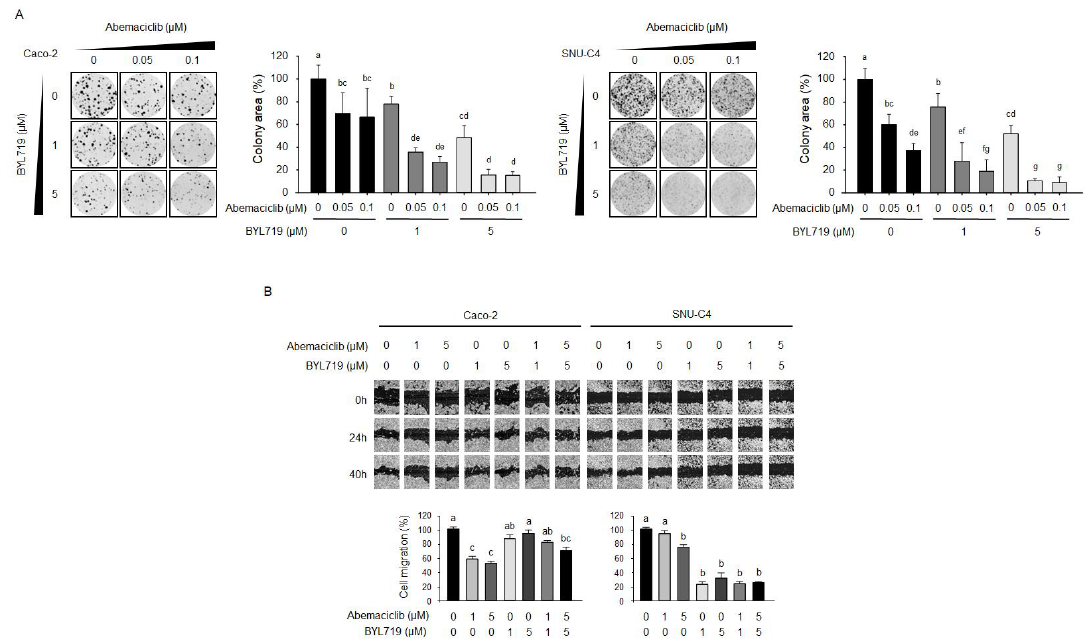
Figure 4. Combination effects of abemaciclib and BYL719 on colony formation and migration in Caco-2 and SNU-C4 cell lines. ( A ) Colony-forming assays were conducted in Caco-2 and SNU-C4 cells treated with 0, 0.05, and 0.1 μM abemaciclib and/or 0, 1, and 5 μM BYL719 for 10 days. Data represent the mean ± S.D. Different letters (a, b, c, d, e, f, g) indicate significant differences ( p < 0.05). ( B ) The